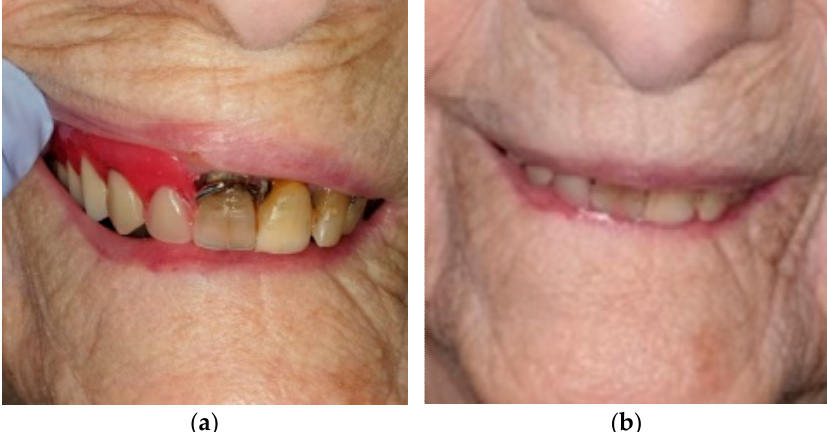
Figure 5. ( a ) Test of the removable prosthesis with teeth mounted on wax for any modifications; ( b ) Finished prosthesis.